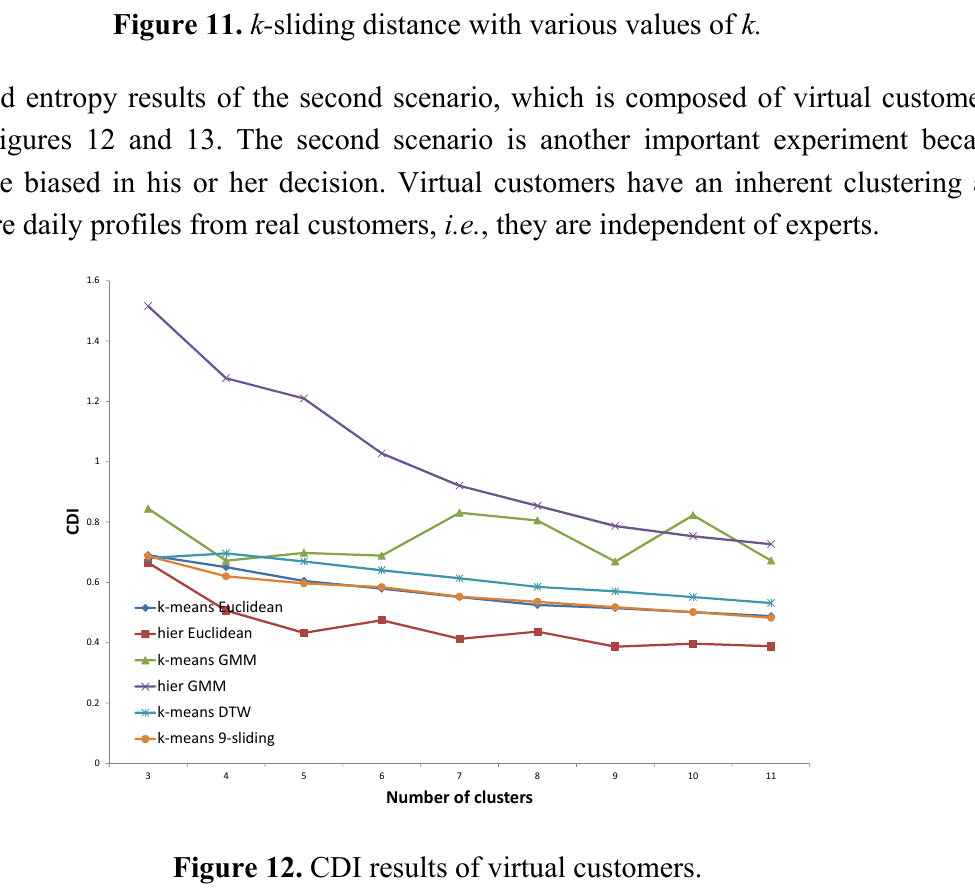
Figure 11. k- sliding distance with various values of k.